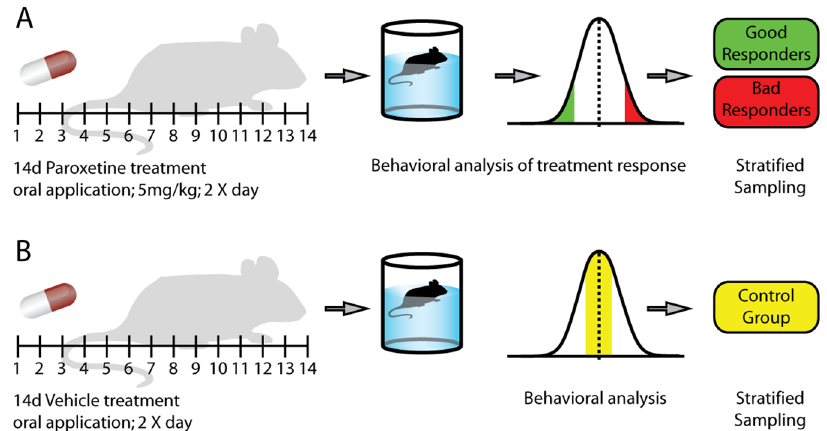
Fig 1. Murine approach modeling heterogeneity of treatment outcome in the FST. This figure illustrates the underlying hypothesis:in a large number of animals that are treated with an antidepressant, animalsare stratified into subgroupsof extremes accordingto their time-floating behavior.To allowfor the distinctionof effects truly related to the phenomenon of response(and not treatment per se), a second group of animalsis treated with a vehicleunder identicalconditions. FST, forced swim